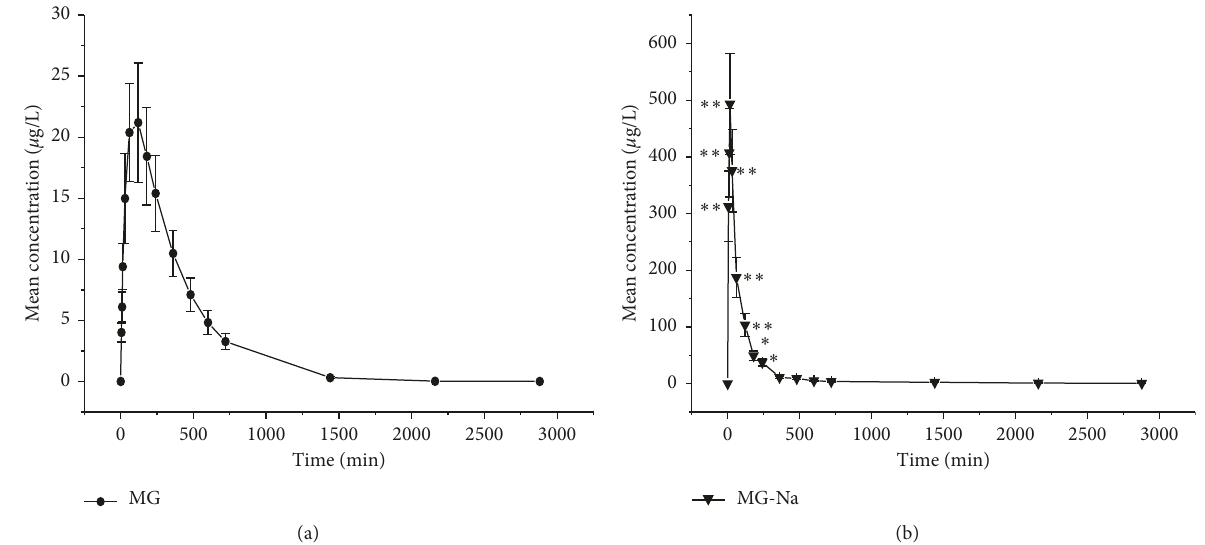
Figure 2: The plasma concentration-time curve of MG and MG-Na. The C-Tcurve after oral administration of MG (a) and the C-Tcurve after oral administration of MG-Na (b). ∗ P < 0 . 05 indicates significant differences from the MG; ∗∗ P < 0 . 01 indicates highly significant differences from the